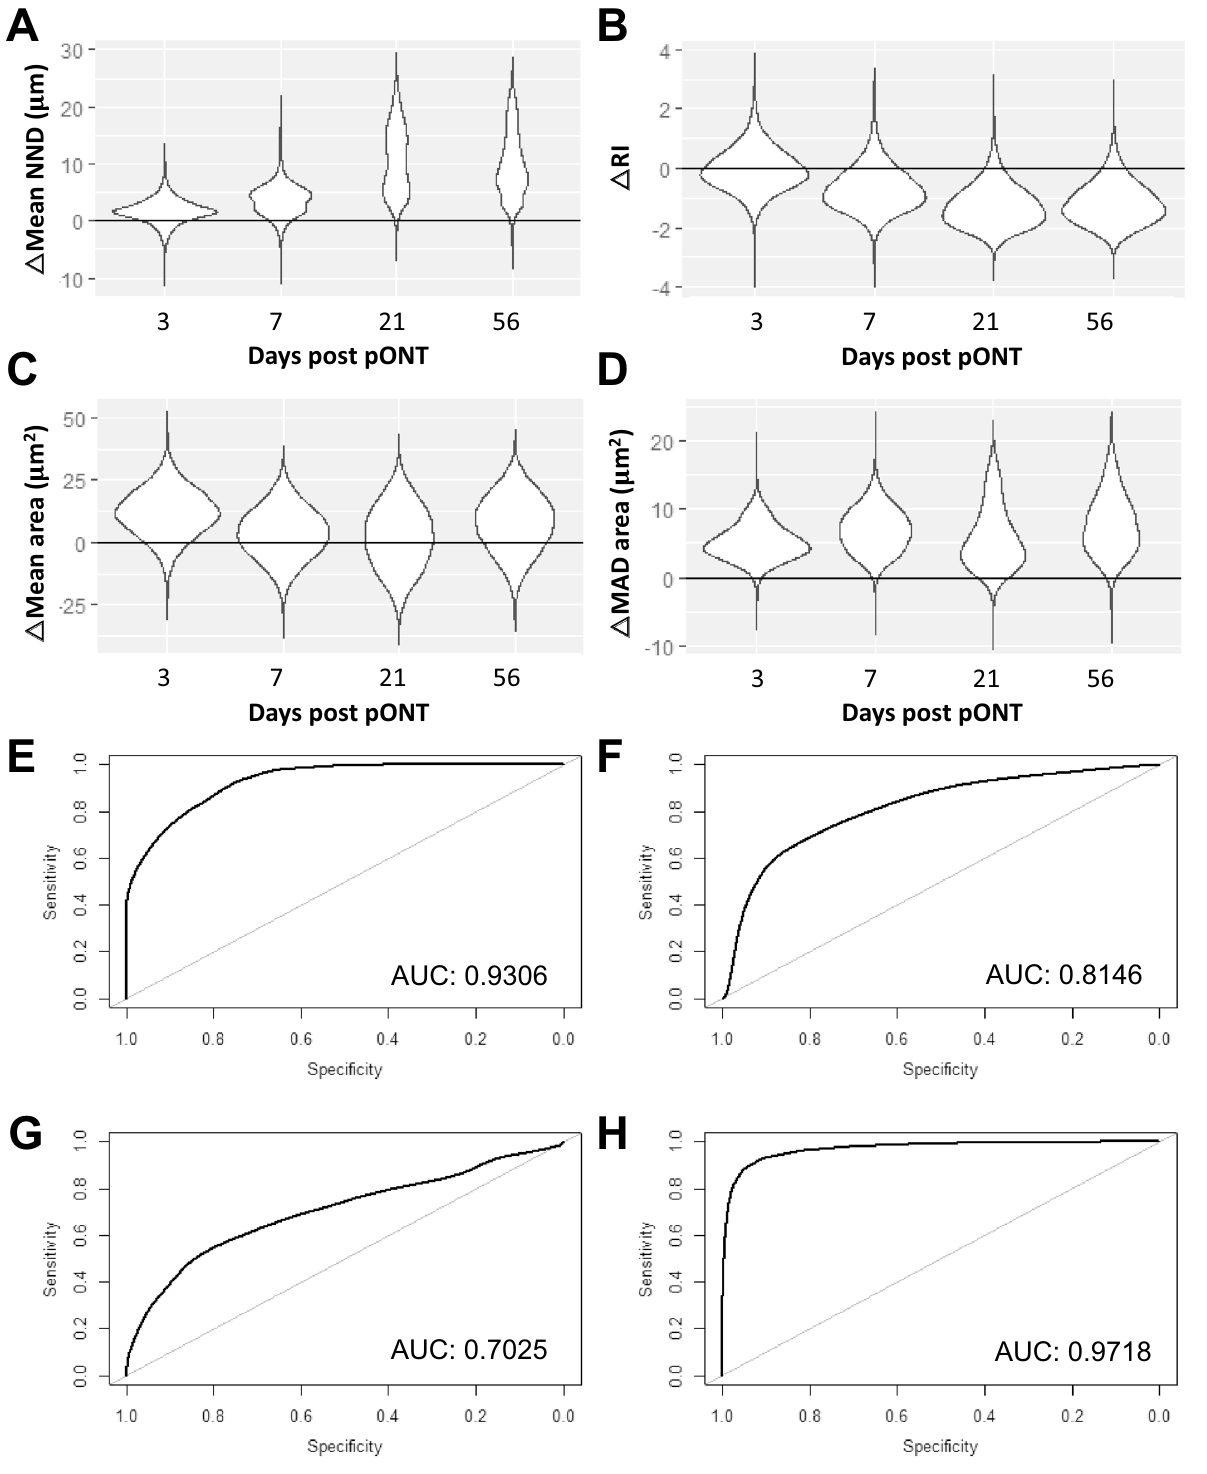
Figure 7. Determination of the diagnostic utility of subsampling the RGC population in the pONT model using a Spatial Bootstrapping versus naive controls. ( A – D ) Difference between pONT and Naive retina randomly subsampled 100 000 times as described in the text and corresponding ROC curves ( E – H ). Results compared include ( A , E ) Nearest Neighbour Distance (NND), ( B , F ) Regularity Index (RI), ( C , G ) Mean RGC size and Mean absolute deviation in RGC size ( D , H ). A table with the median and 95% confidence intervals for the bootstrapping results has been added in supplement (Suppl. Table